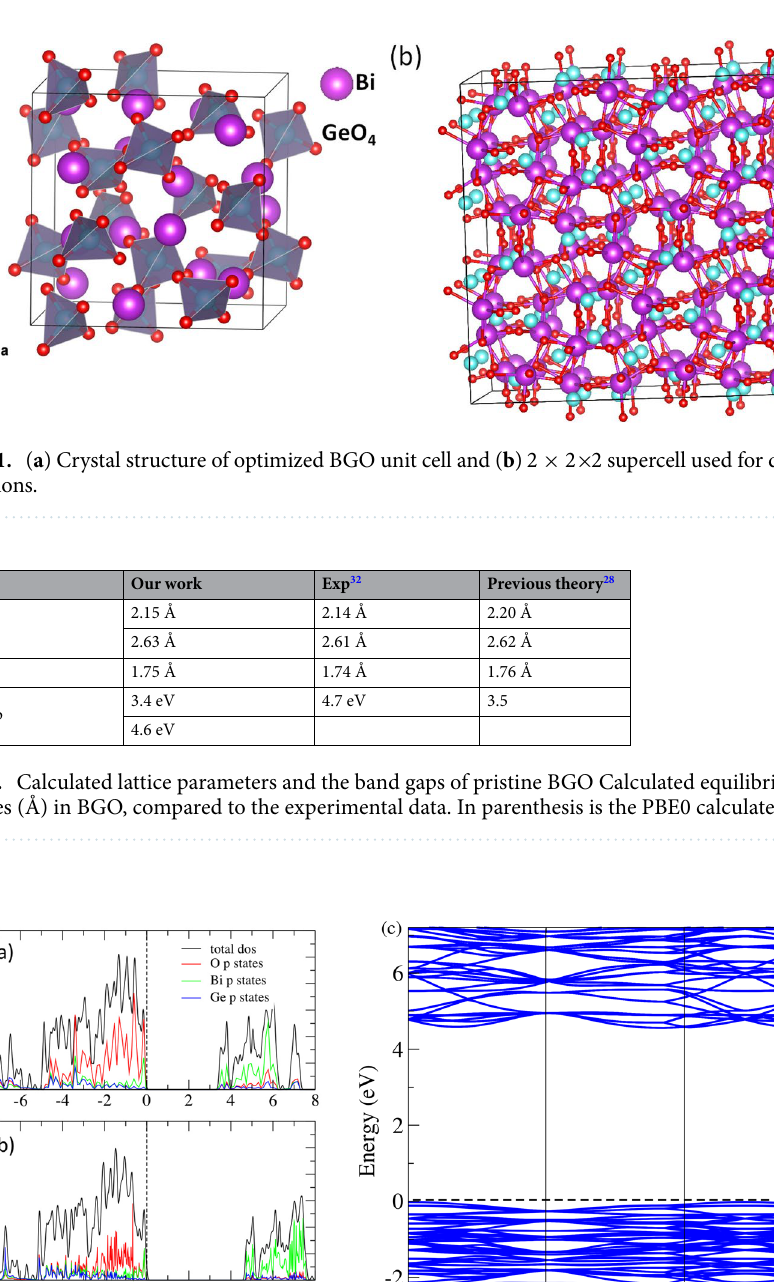
band gap.The band structures (Fig. 2c) calculated along calculated along Ŵ → H → N → Ŵ → P → H|P high sym- metry path of the Brillouin zone further supports the information obtained from the density of state plot shown in Fig. 2b. It is worth noting that our calculated band gap using the PBE0 significantly improves the band gap previously obtained using PBE-GGA functionals (see Table 1). The electronic band gap of a material is a valuable feature that provides a deep understanding of its electronic, defect and optical properties. From our investigation, it was found that, the PBE0 approximation improves greatly the value of the band gap energy. Infact, PBE0 approximation improves, significantly, the calculated gap value better than the conventional GGA approximation. Llalic and coworkers 13 have previously carried out first- principles calculations, including spin orbit coupling on BGO, while certain features were found to be improved in comparison to standard DFT, the band gap was underestimated. Using PBE0, key features of the electronic states are reproduced while a much improved band gap is also obtained. An accurate prediction of the band gap